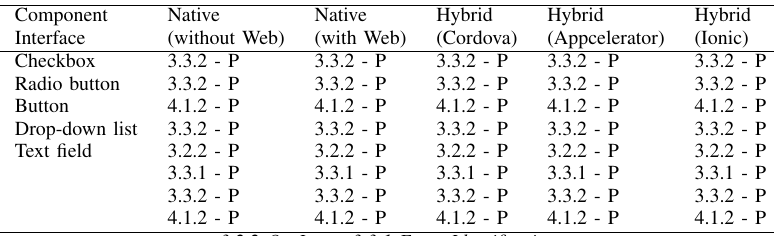
TABLE VIII A CCESSIBILITY INSPECTION OF CONTROLS , FORMS AND FUNCTIONALITIES